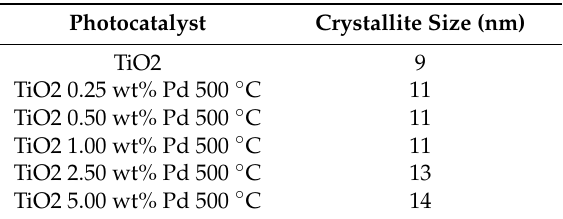
Table A2. Lattice Parameters for TiO 2 and Pd doped TiO 2.